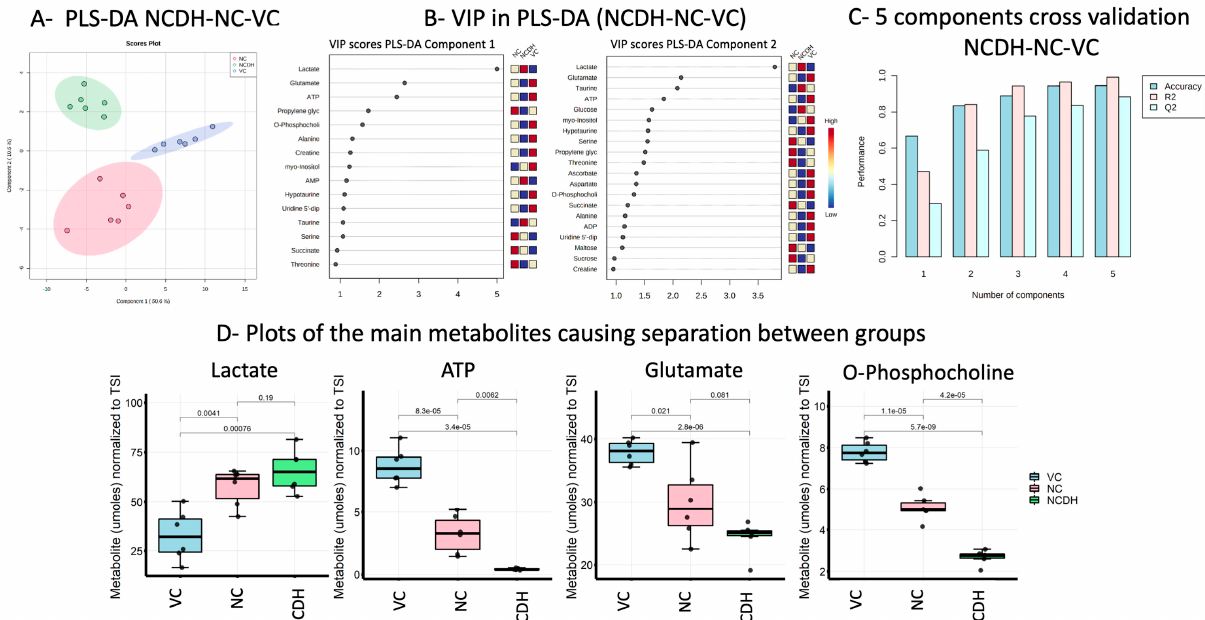
Figure 1. CDH fetal lungs’ metabolic profile. ( A ) Loading score plot of partial least square discriminant analysis (PLS-DA) comparing vehicle control (VC: blue), nitrofen control (NC: red), and nitrofen-CDH model (NCDH: green) with component 1 (Explained variance (EV) 50.6%), component 2 (EV 10.5%), and 95% confidence interval, and ( B ) the corresponding PLS-DA metabolites variable importance in projection (VIP) from component 1 and 2. ( C ) 5 components cross-validation assessment of the PLD-DA model showing the accuracy of 0.83, Q2 of 0.59, and R2 of 0.84 for 2 components. ( D ) Box plots of the selected altered metabolites between the treatment groups with p -values based on the Student’s t -test: VC—blue, NC—red, and